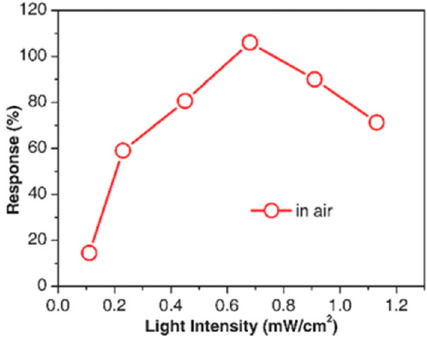
Figure 56. ( a ) Transmission electron microscopy (TEM) image of a Bi 2 O 3 -core/ZnO-shell nanobelt; ( b ) Dynamic NO 2 sensing plot of pure Bi 2 O 3 nanobelts in dark, Bi 2 O 3 -core/ZnO-shell nanobelt in dark and with UV illumination. Reproduced with permission from [80].